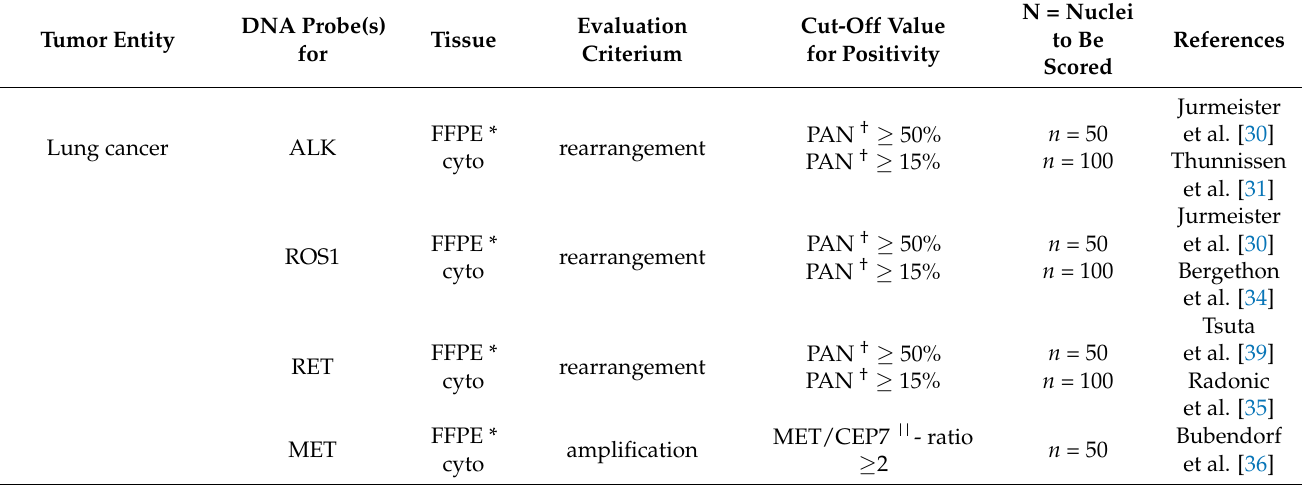
Table 1. Evaluation criteria currently used for routine FISH analysis of